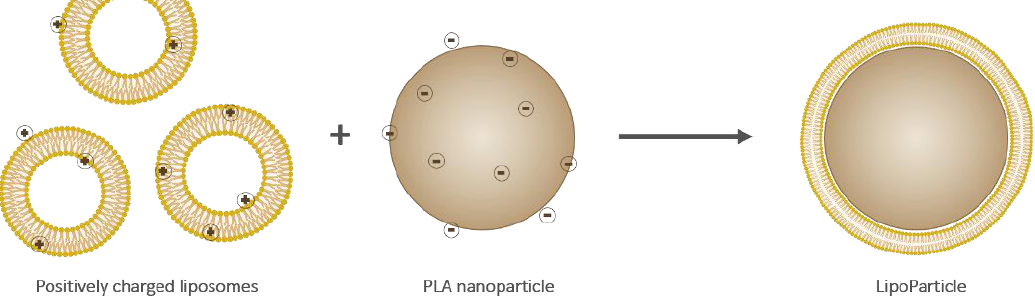
Figure 1. Schematic representation of cationic liposomes ( left ), an anionic poly(lactic) acid (PLA) nanoparticle ( middle ), and a resulting LipoParticle ( right ). Note that the scale and charge proportions are not respected. Table 1. Characterization of poly(lactic) acid nanoparticles (PLA-NP), 15/85 mol/mol 1,2-distearoyl-sn-glycero-3- phosphocholine (DSPC)/1,2-dioleoyl-3-trimethylammonium-propane (DOTAP) liposomes and LipoParticles (LP). Results are represented as mean ± SD of different batches ( n = 3 for PLA-NP, n = 4 for liposomes and LP).